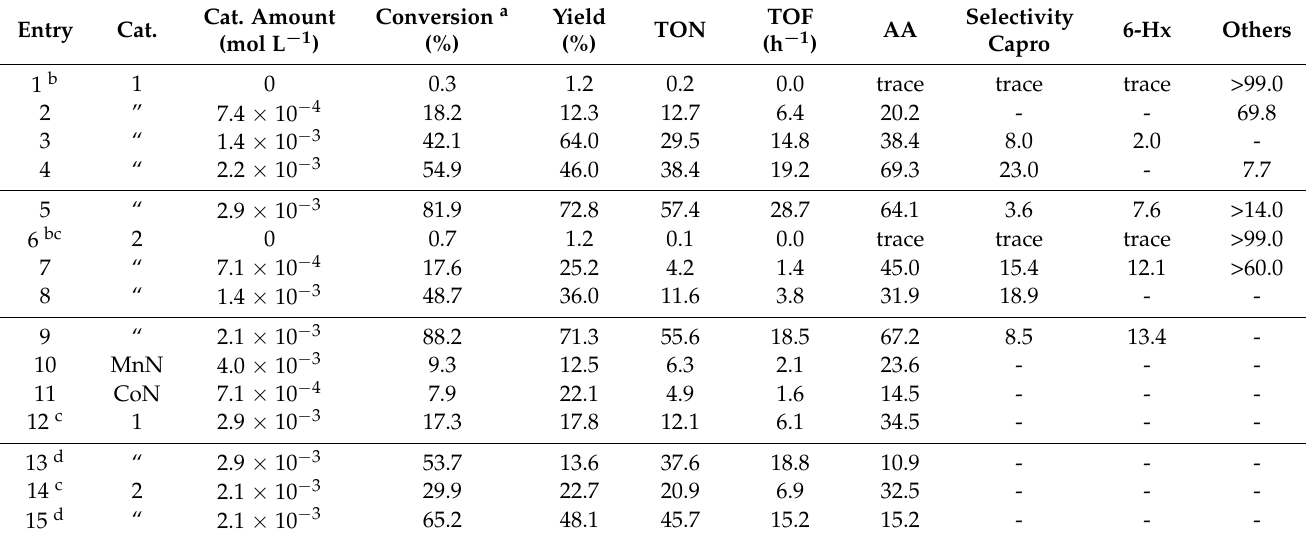
Table 2. Selected catalytic activity of compounds 1 and 2 for cyclohexanone